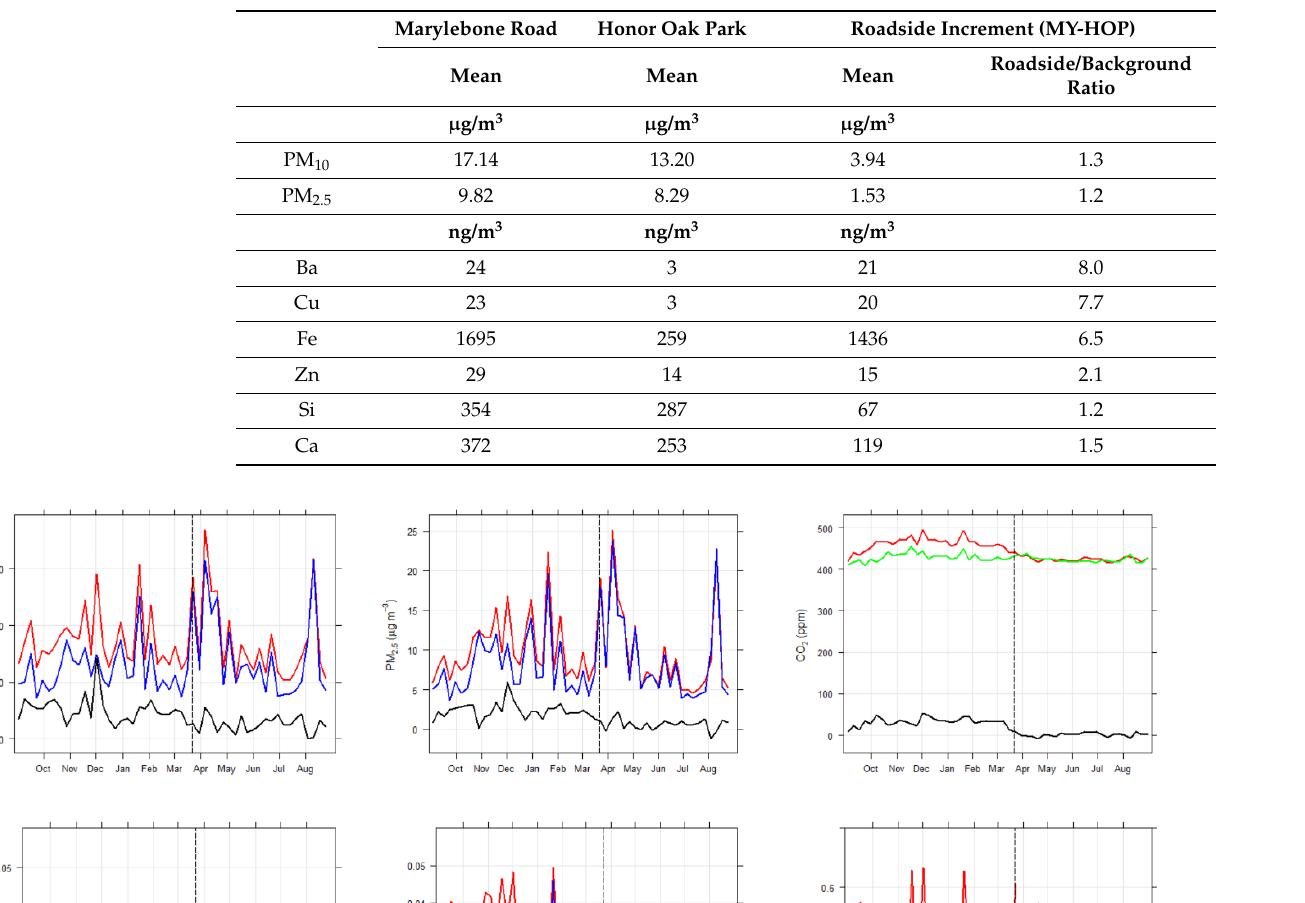
Table 2. Campaign average roadside (MY), background (HOP), and roadside increment (MY-HOP) concentrations ( µ g/m 3 /ng/m 3 ).